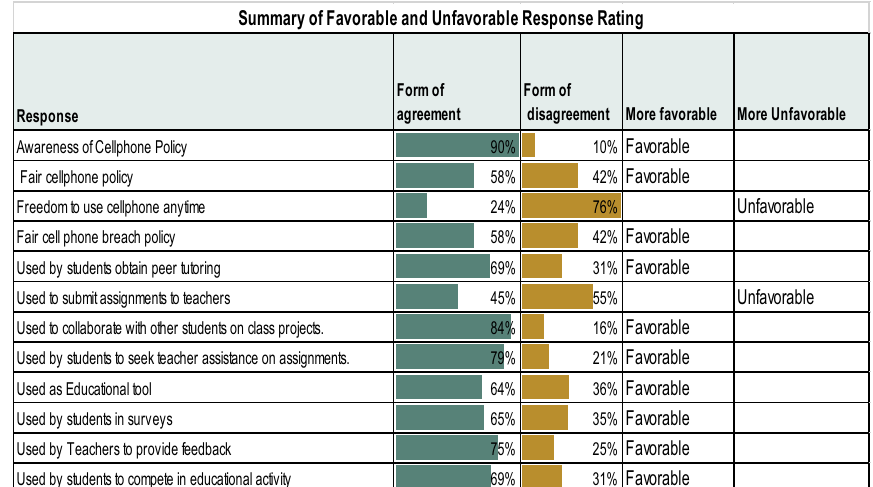
Table III. Mean and SD – perception as a